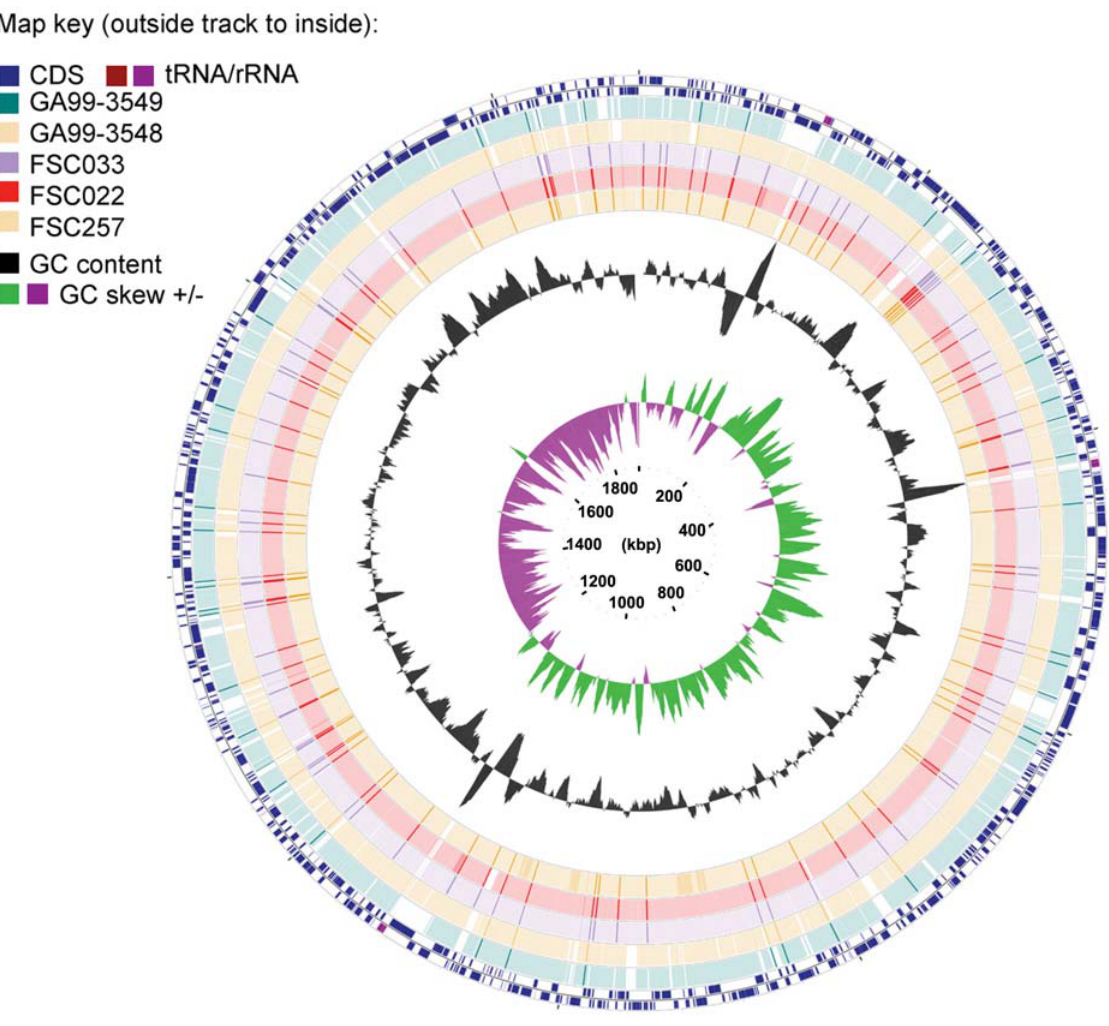
Figure 1. Pairwise alignments between five new Francisella genome sequences and a reference genome exhibit . 95% sequence conservation. Genome comparative maps were constructed using CGview software to map pairwise blastn alignments between several Francisella genomes (minimum percent identity=95 and expected threshold=1e-5). Specifically, five newly sequenced Francisella genomes ( F. tularensis subsp. holarctica FSC257 and FSC022; F. tularensis subsp. tularensis FSC033; and F. tularensis subsp. novicida GA99-3548, and GA99-3549 strains) were aligned to the F. tularensis subsp. holarctica OSU18 reference sequence (outside blue track of genome map). A high degree of similarity between the genomes ( . 95%) is evident from the continuous blocks of synteny (colored